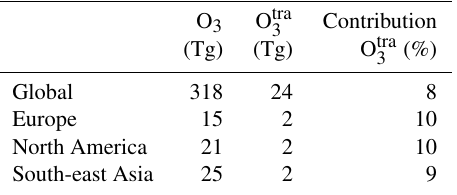
Table 6. Burden of O 3 and O tra Average values for the period 2006–2010.